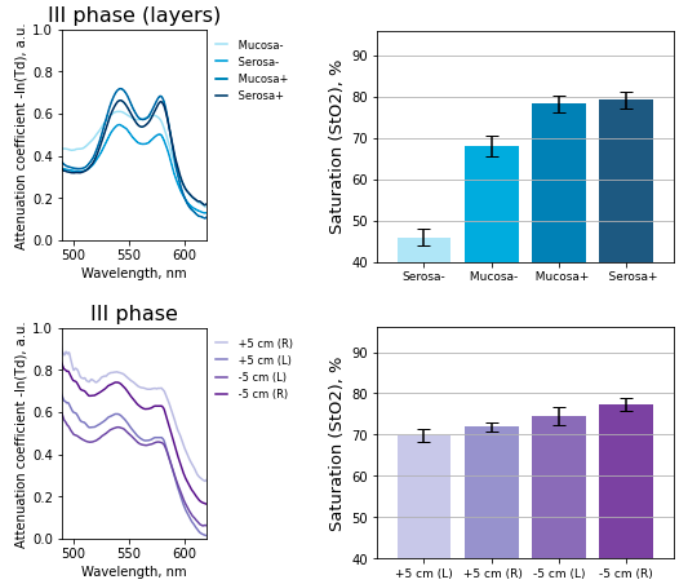
Figure 7. Histogram of tissue saturation values in the intestinal wall before anastomosis. The measurements were carried out in layers and with an intraluminal